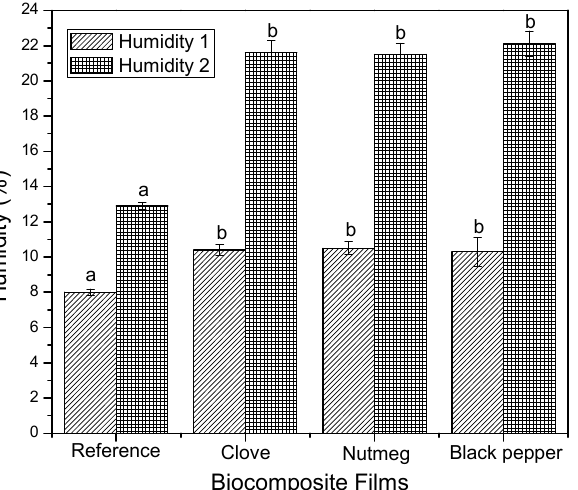
Figure 3. Humidity content of biocomposite films with oleoresins and reference before and after conditioning. Different letters in the same column indicate significant differences ( p < 0.05).